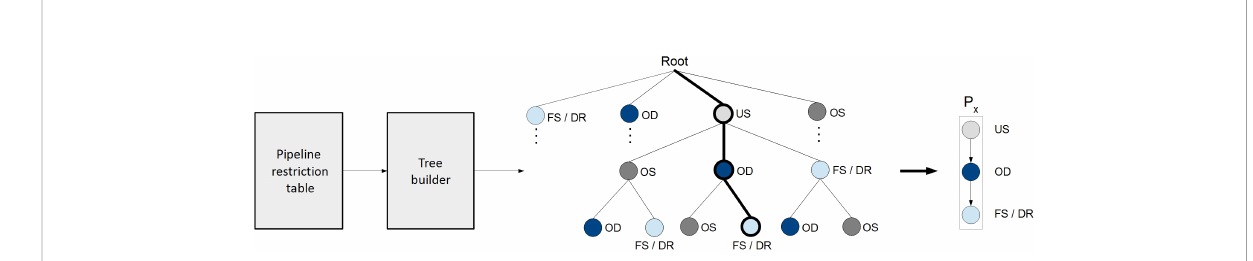
FIGURE 2 Pipeline tree generation based on the pre-determined restriction conditions. The pipeline restriction table contains rules regarding permitted, consecutive data preparation steps and the permitted number of repetitions of particular data preparation methods. The Tree builder generates a tree of all possible data preparation pipelines, satisfying the rules de fi ned in the Pipeline restriction table. A particular pipeline is de fi ned as the ordered steps of data preparation methods from tree root to any leaf. P x , randomly selected data preparation pipeline; FS, Feature selection; DR, Dimensionality reduction; OD, Outlier detection; US, Undersampling; OS,